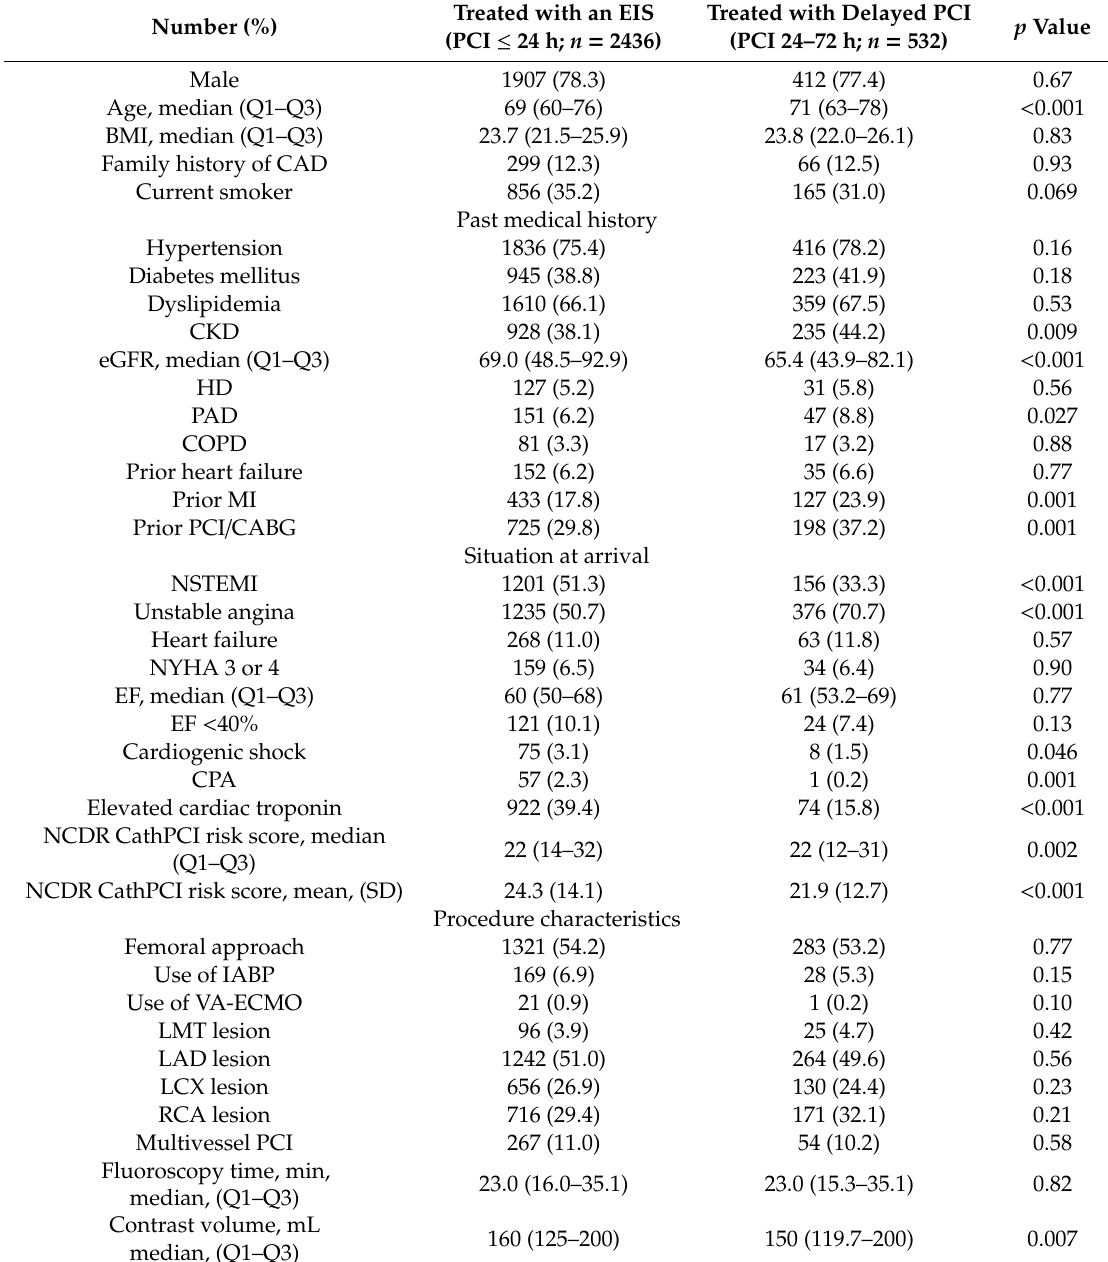
Table 1. Baseline